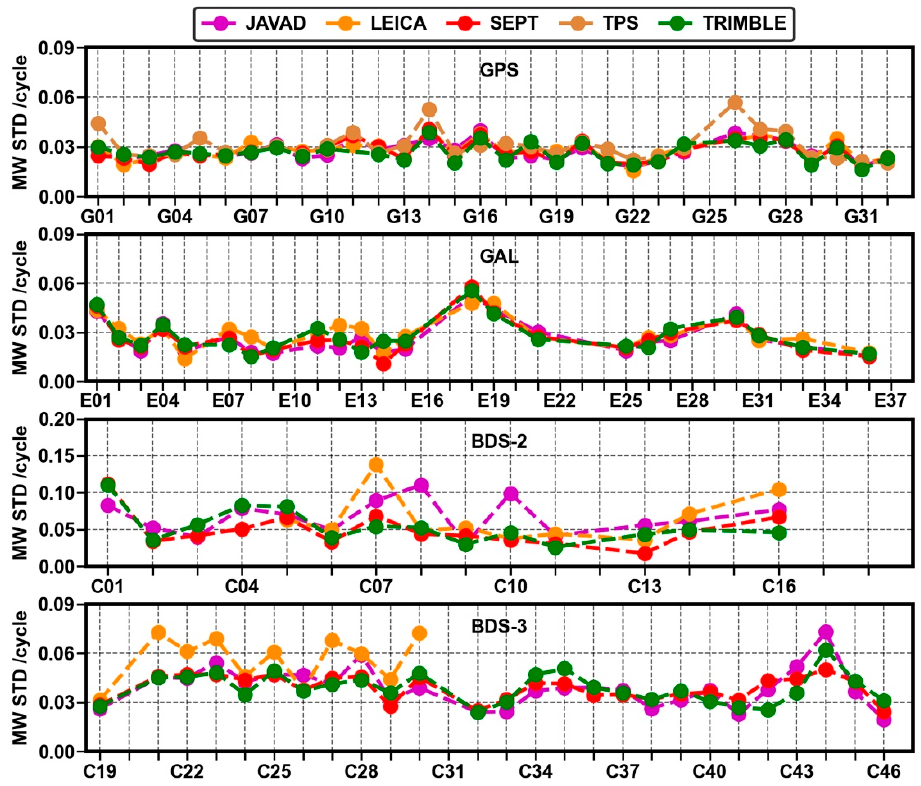
Figure 4. Average STDs of the MW SDBs for multi ‐ GNSS from DOY 45 to 51, 2021.